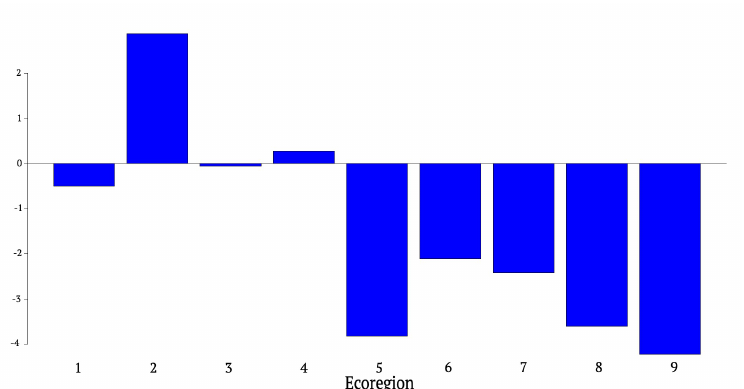
Figure 11. Partial dependence plot on the explanatory variable ecoregions. See Table 2 for class